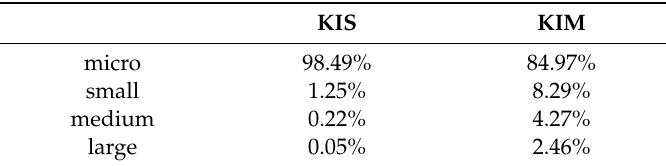
Table 2. Comparison of KIM and KIS in terms of size of enterprise.